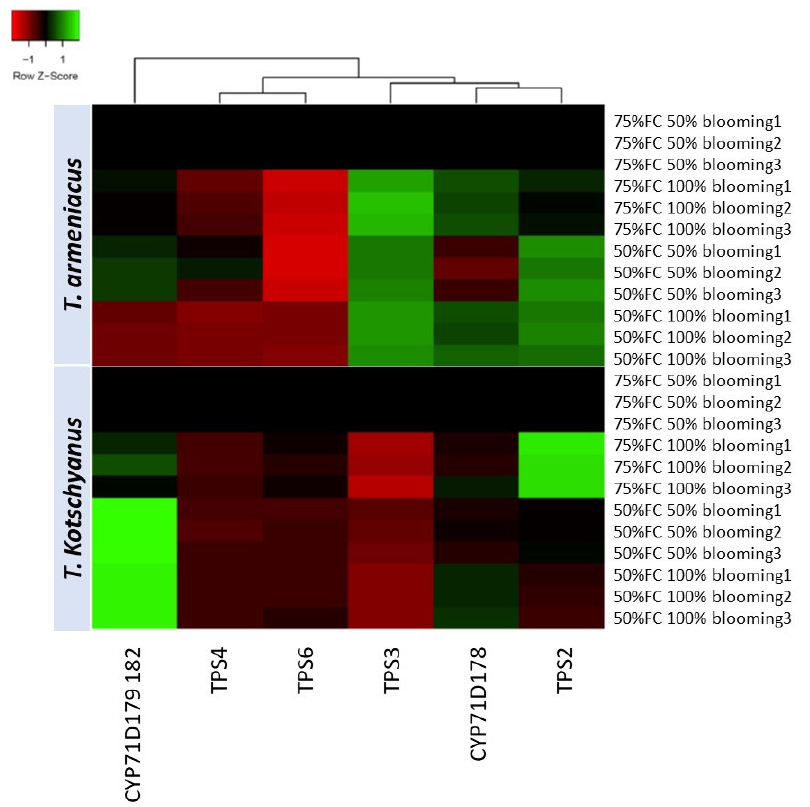
Figure 4. Heat map of relative transcript accumulation (log2) of the terpene biosynthetic pathway across treatments. The effect of irrigation regime (75 or 50% of field capacity) on relative mRNA abundance of two Thymus species ( T. armeniacus , T. kotschyanus ) was investigated at two develop ‐ mental stages (50 and 100% blooming). This was assessed using real ‐ time RT ‐ qPCR and three